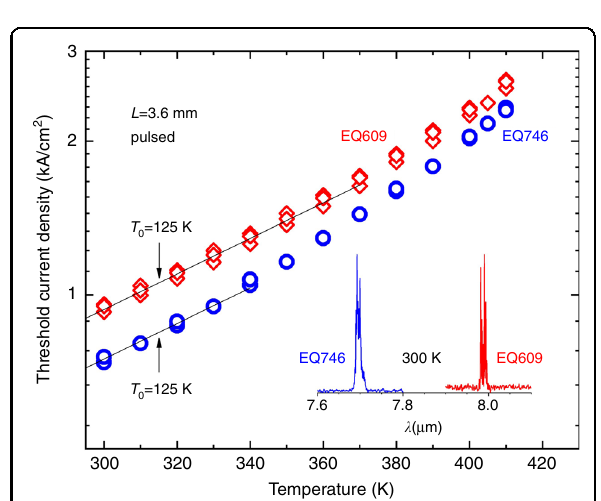
Fig. 15 Threshold current density of QCLs grown on Si (red symbols, EQ609) and on InAs (blue symbols, EQ746) as a function of temperature and typical emission spectra. Reprinted from ref. 34 , used in accordance with the Creative Commons